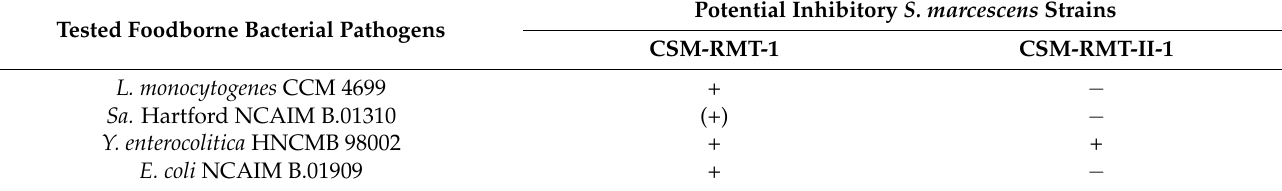
Table 2. Inhibitory effect of S. marcescens CSM-RMT-1 and CSM-RMT-II-1 strains on the tested foodborne pathogenic bacteria examined with the agar spot method after one, two, three and six days of incubation (based on reference